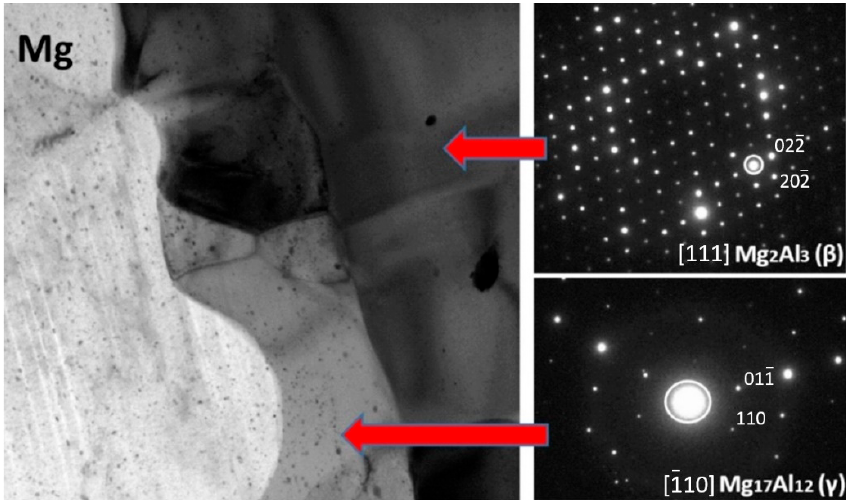
Figure 14. TEM image of AZ31/AA1050 joint microstructure after hot-rolling at 400 °C with selected area diffraction patterns (SAED). TEM lamella position at Figure 13A.